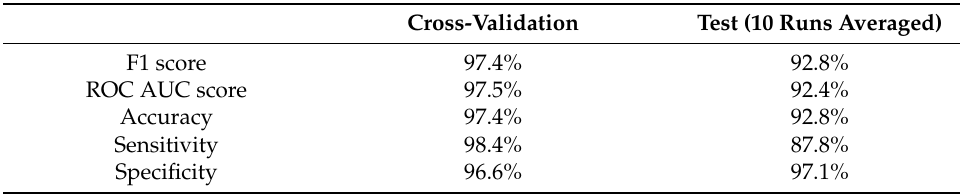
Table 11. Cross-validation and test scores for Configuration Table 12. Tested configurations for the overlapping dataset.